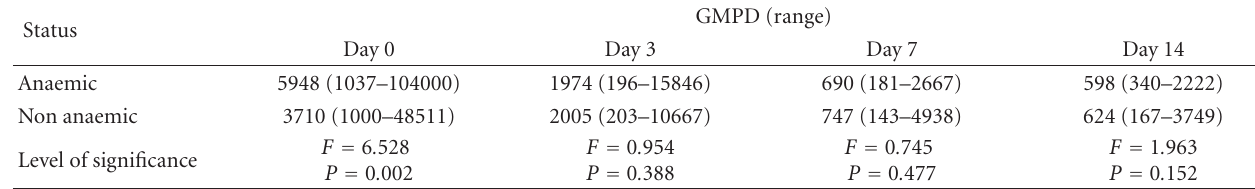
Table 4: E ff ect of parasitaemia on anaemia in patients attending CAMEF during the in vivo study, 2007-2008 following treatment with Malartin and